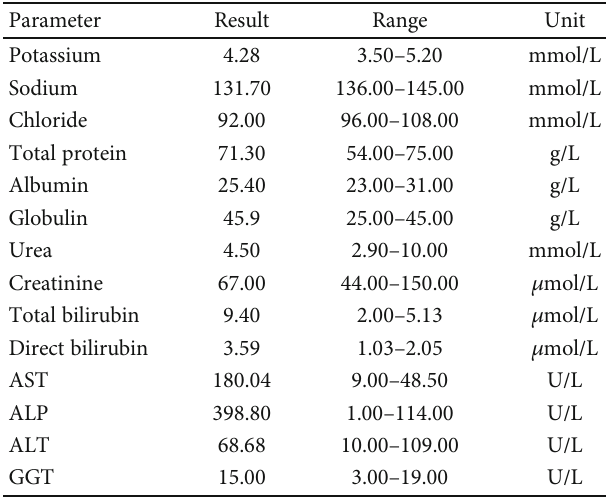
Table 2: Serum biochemistry